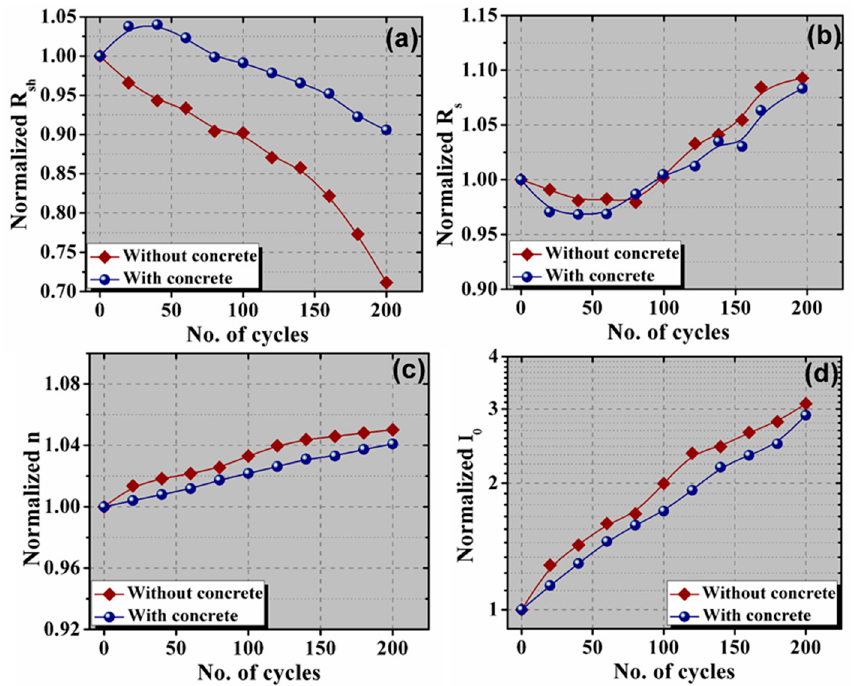
Figure 9. Variation of ( a ) shunt resistance, ( b ) series resistance, ( c ) diode ideality factor, and ( d ) reverse saturation current with thermal cycling.